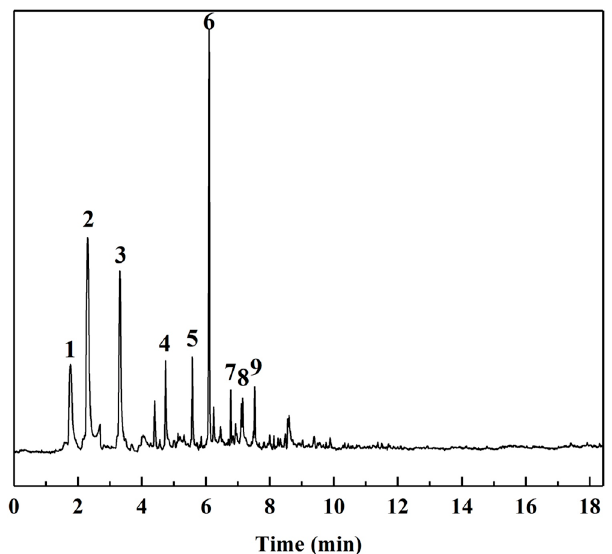
Figure 9. GC/MS chromatogram of evolved gas taken from the insoluble mass of cured adhesive heated at 500 °C for 60 s. Table 2. Identified chemical compounds in evolved gas derived from insoluble mass of cured SADP adhesive heated at 500 °C for 60 s.